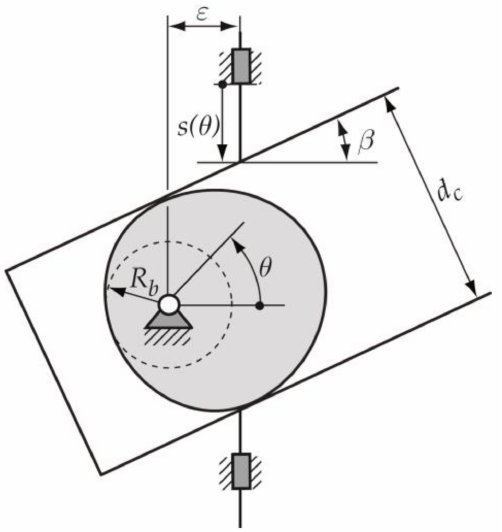
Figure 3. Geometric parameters in a constant-breadth cam mechanism: R b , radius of the base circle of the cam; ε , offset of the follower; β , inclination angle of the translating follower; and d c , the breadth of the cam.